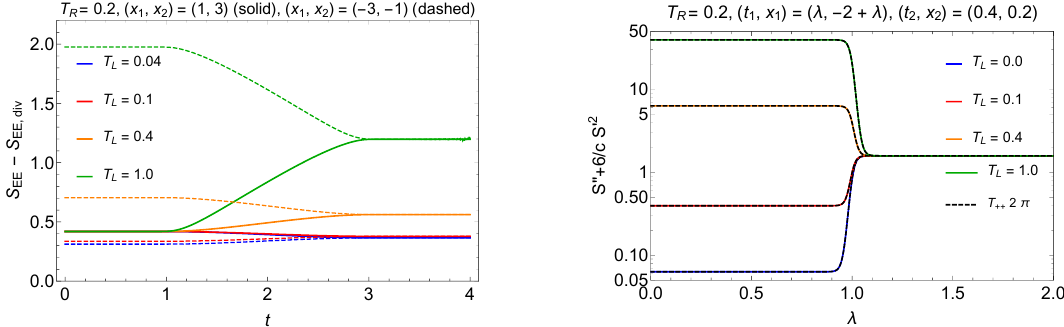
Figure 1: HEE behavior (left) and QNEC saturation (right) for far from equilibrium